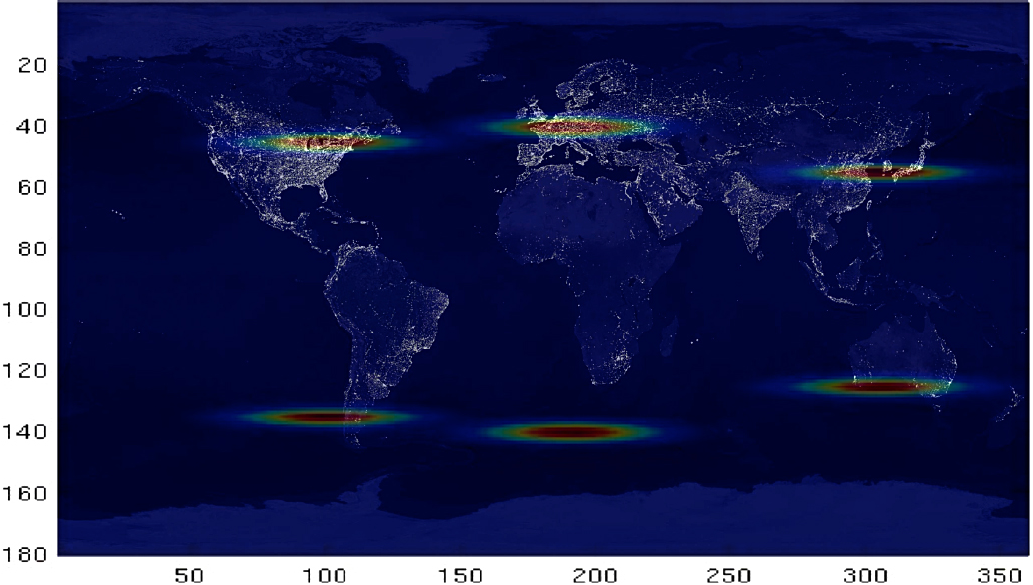
Figure 1. Earth at night with Quebec-like events over the Americas (scenario 1), Europe and the southern ocean (scenario 2), and East Asia and Australia (scenario 3). The red area has the highest storm intensity normalized to 1. The storm’s intensity has a Gaussian falloff.